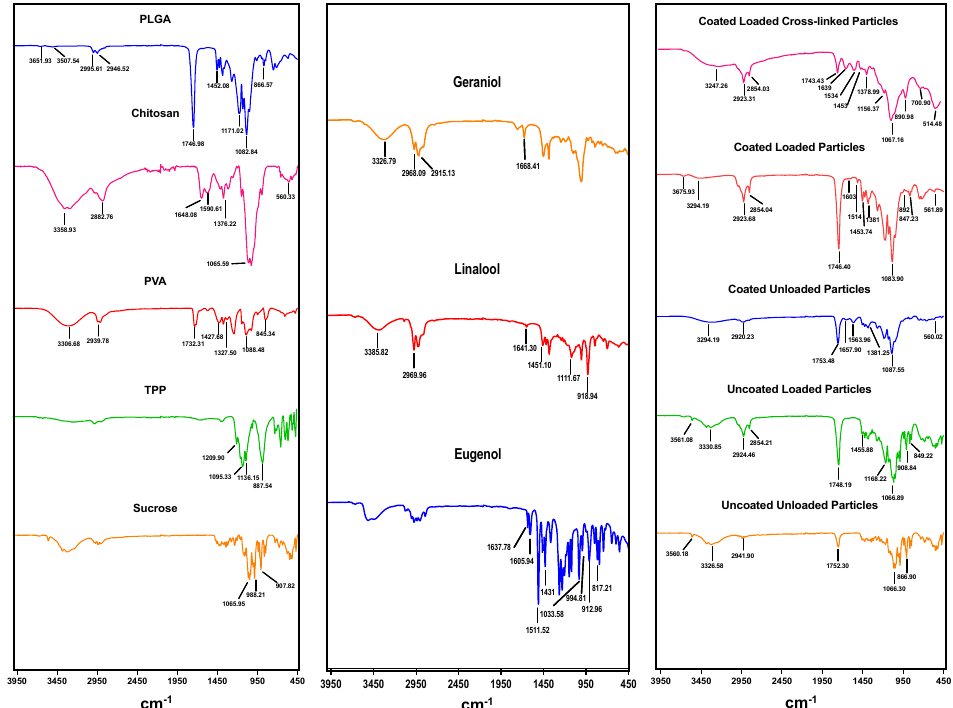
Figure 5. Fourier transform-infrared spectra of pure chemicals used to prepare the particles, EO components, plain and loaded PLGA particles (uncoated or chitosan coated), and crosslinked particles prepared in the study.